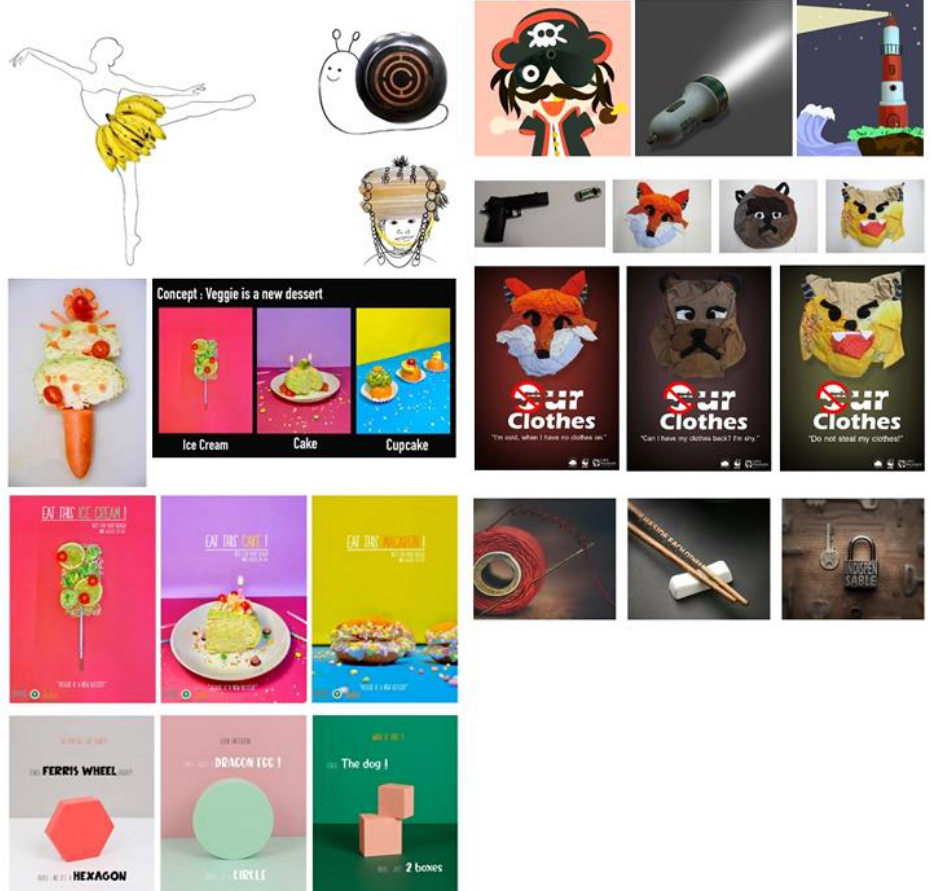
Figure 2. Examples of some creative works of student from the weak group form 2